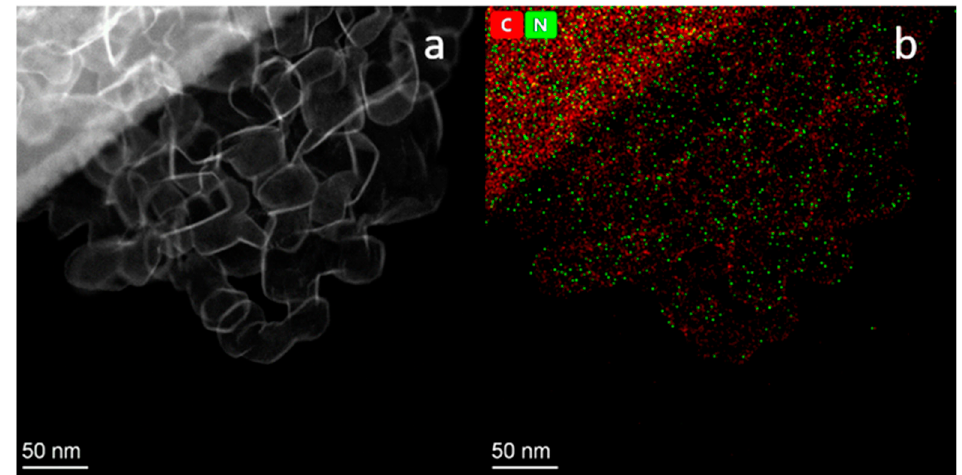
Figure 3. HAADF STEM image of 0.4% Pt/N-graphene (H 2 PtCl 6 ) catalyst ( a ) and EDX mapping of nitrogen and carbon atoms ( b ).